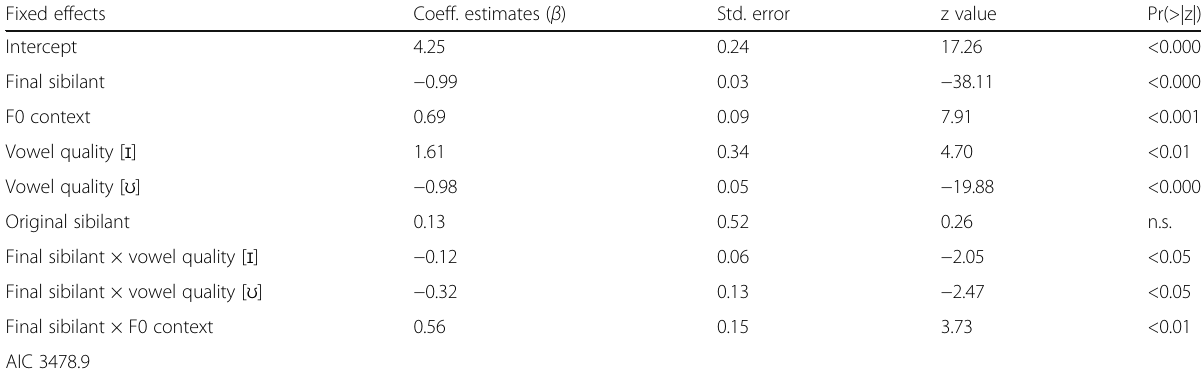
Table 3 Table of covariates, results summary of the binomial logistic regression analysis Fixed